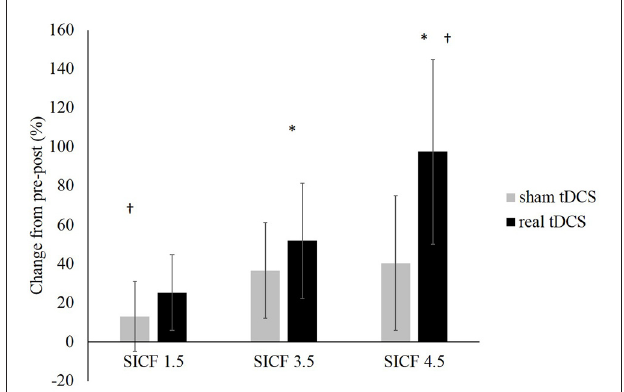
FIGURE 4 | Change in SICF MEP amplitudes (as a percentage of unconditioned MEPs) at ISIs of 1.5, 3.5 and 4.5 ms (all P > 0.05). ∗ Denotes significant difference between SICF 3.5 and 4.5. † Denotes significant difference between SICF 1.5 and